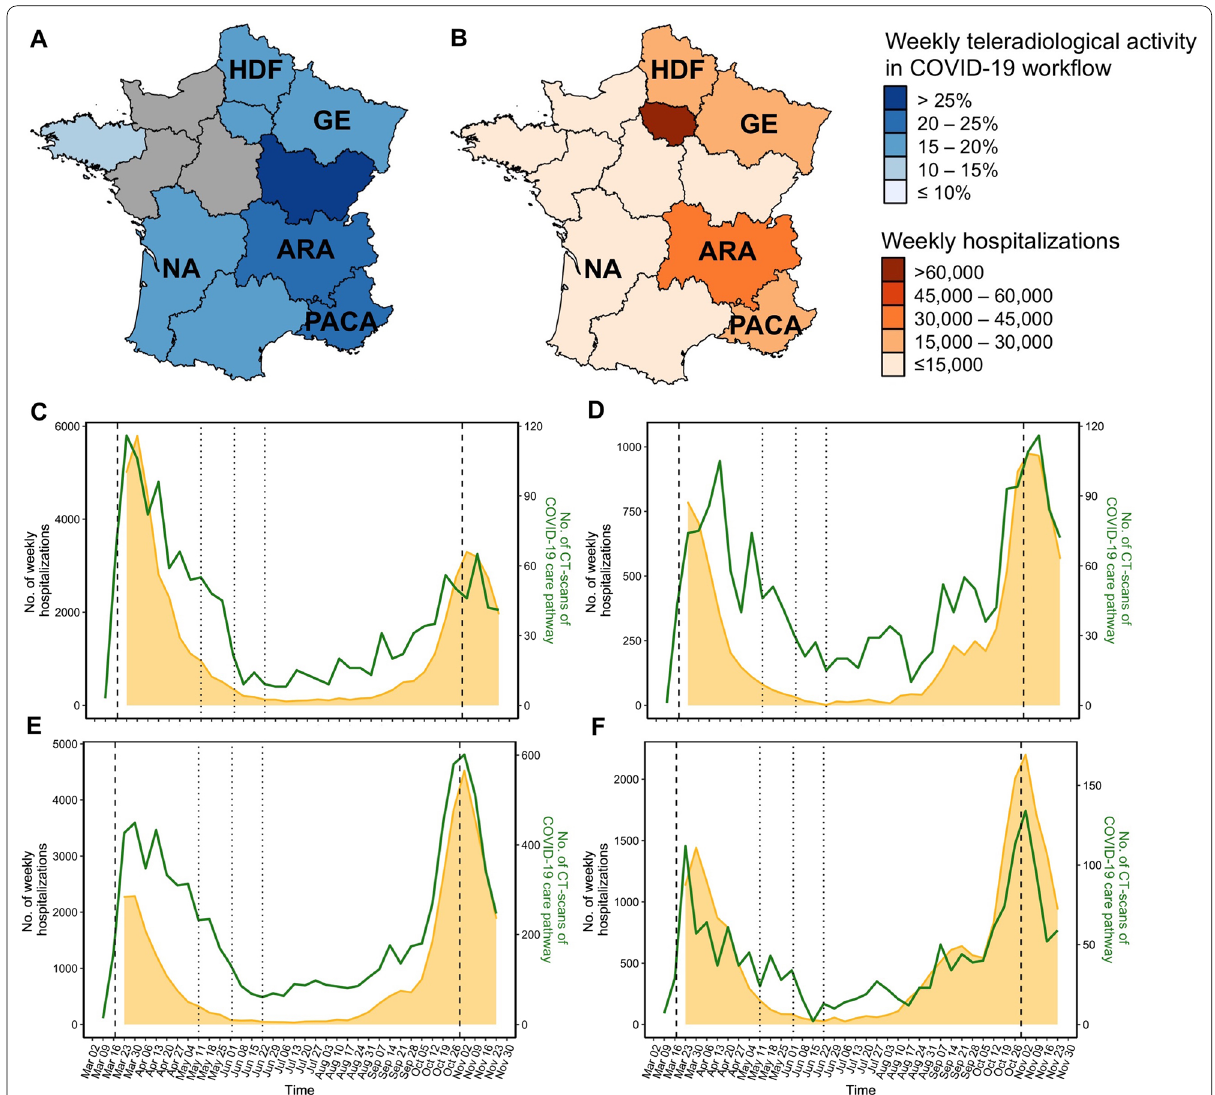
Fig. 6 Regional correlations between the teleradiological emergency time‑series and number of hospitalisations. French regions with colour‑encoding according to the percentage of teleradiological emergency activity in the COVID‑19 workflow ( a ) and the number